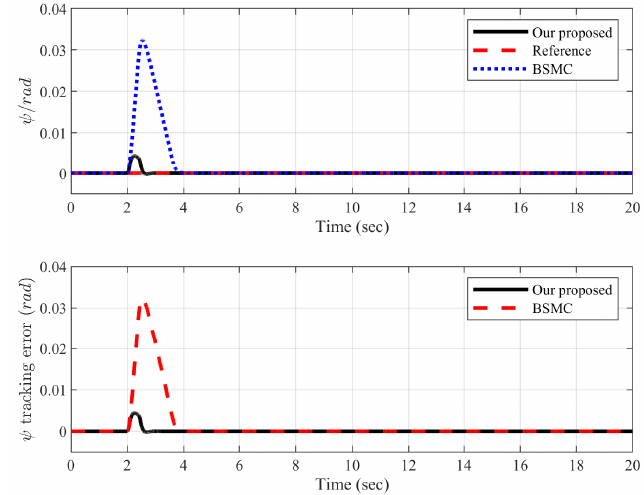
Figure 11. The control performance and tracking errors in relation to the yaw angle.